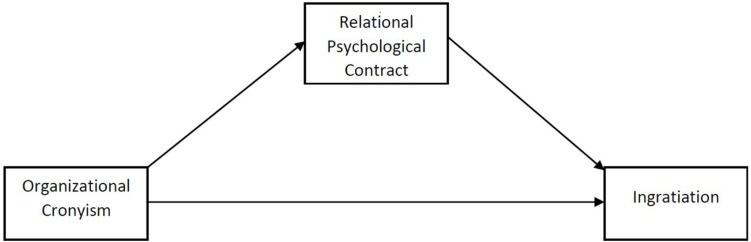
Study framework.